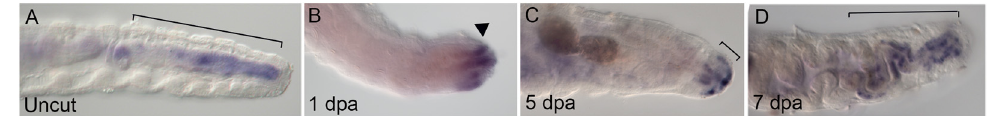
Figure 7. The ParaHox gene CapI-cdx defines new hindgut identity during regeneration. Animals are amputated anterior to CapI-cdx expression domain in the hindgut of uncut animals. CapI-cdx expression in the hindgut of uncut animals ( A ). By 1 dpa, novel expression is initiated in pre-existing tissue near the wound site (arrowhead in B) and gradually becomes localized to new gut tissue in the regenerate at 5 and 7 dpa. ( C,D ). Lines in ( A , C , D ) and arrowhead in ( B ) mark area of expression. A and B are lateral views, C and D are ventral views. Anterior is to the left in all panels. Days post amputation (dpa) is indicated in bottom left corner.